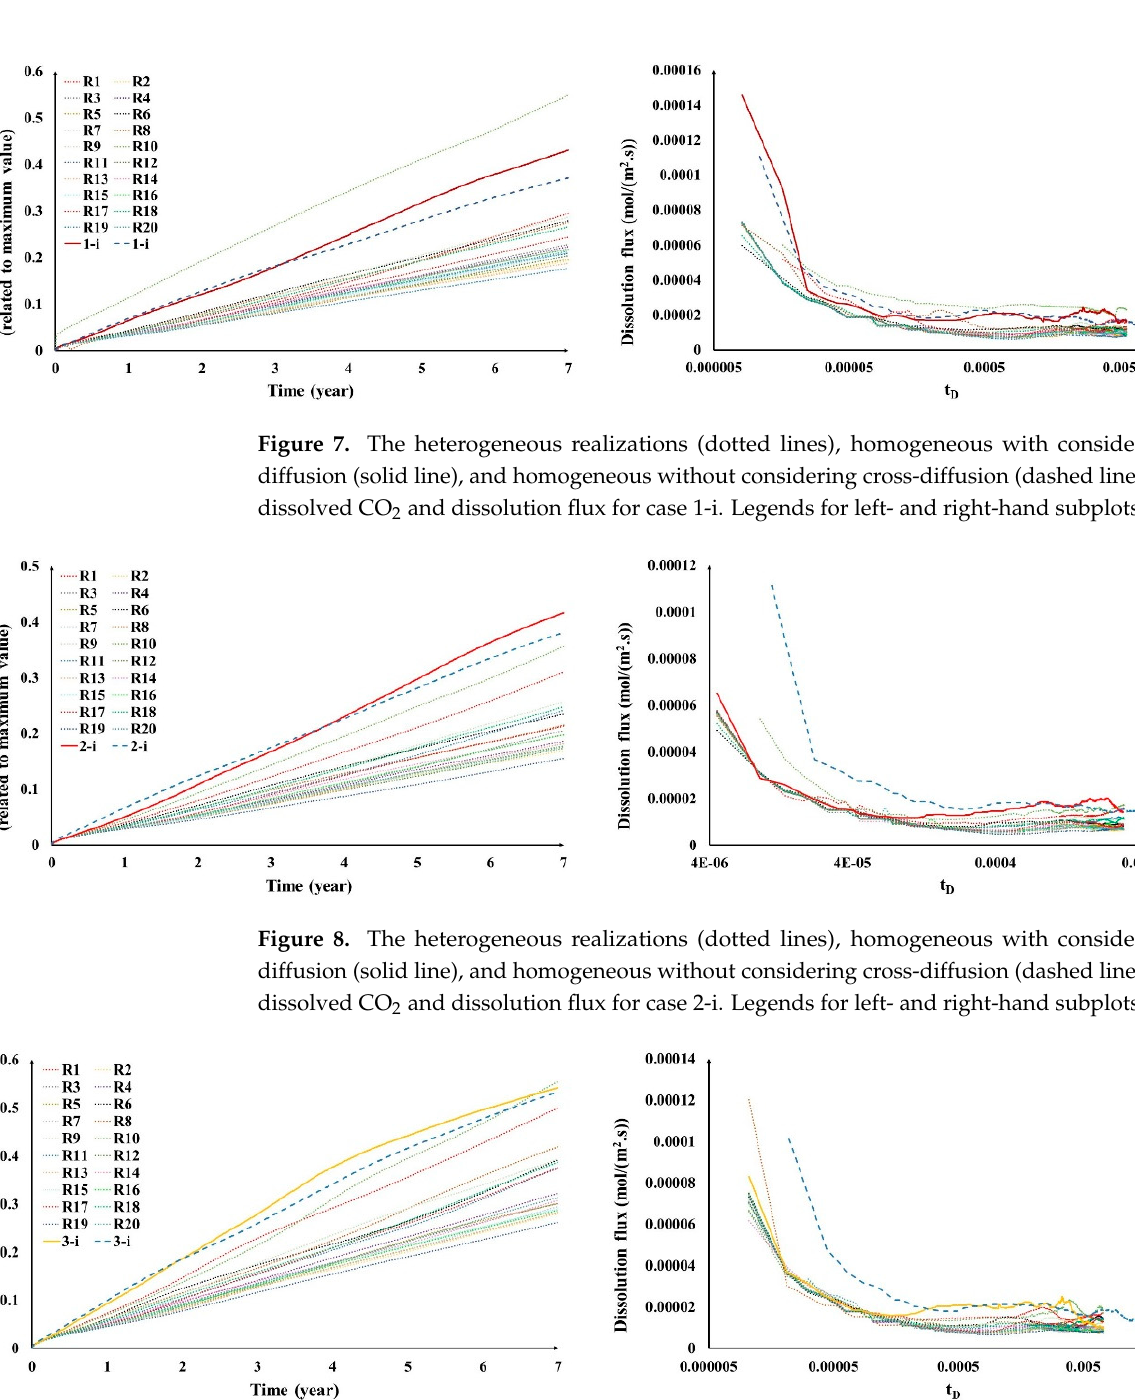
Figure 9. The heterogeneous realizations (dotted lines), homogeneous with considering cross-diffu- sion (solid line), and homogeneous without considering cross-diffusion (dashed line) averaged dis- solved CO 2 and dissolution flux for case 3-i. Legends for left- and right-hand subplots are same.